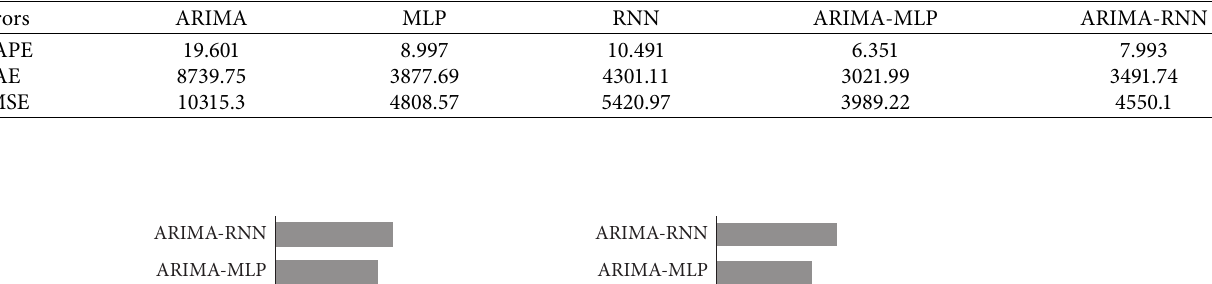
Table 1: Forecasting performance of different